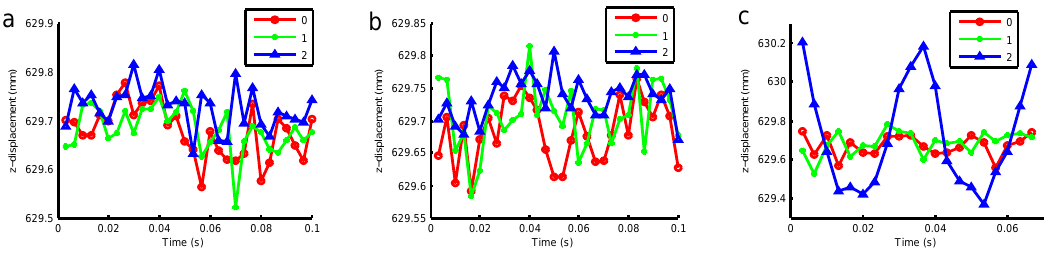
Figure 9. The out-plane motion at different rotation speed with different additional weight at different speed: ( a ) 600 rpm; ( b ) 1200 rpm; and ( c ) 1800